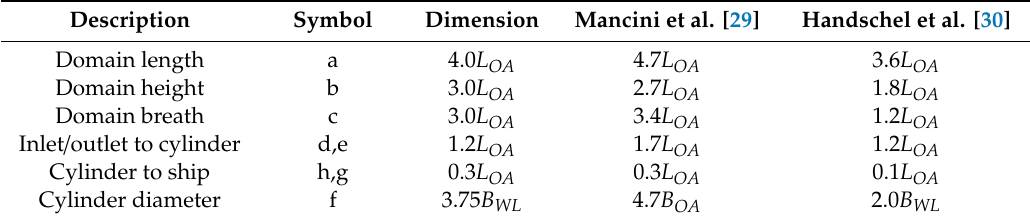
Table 3. Presentation of domain